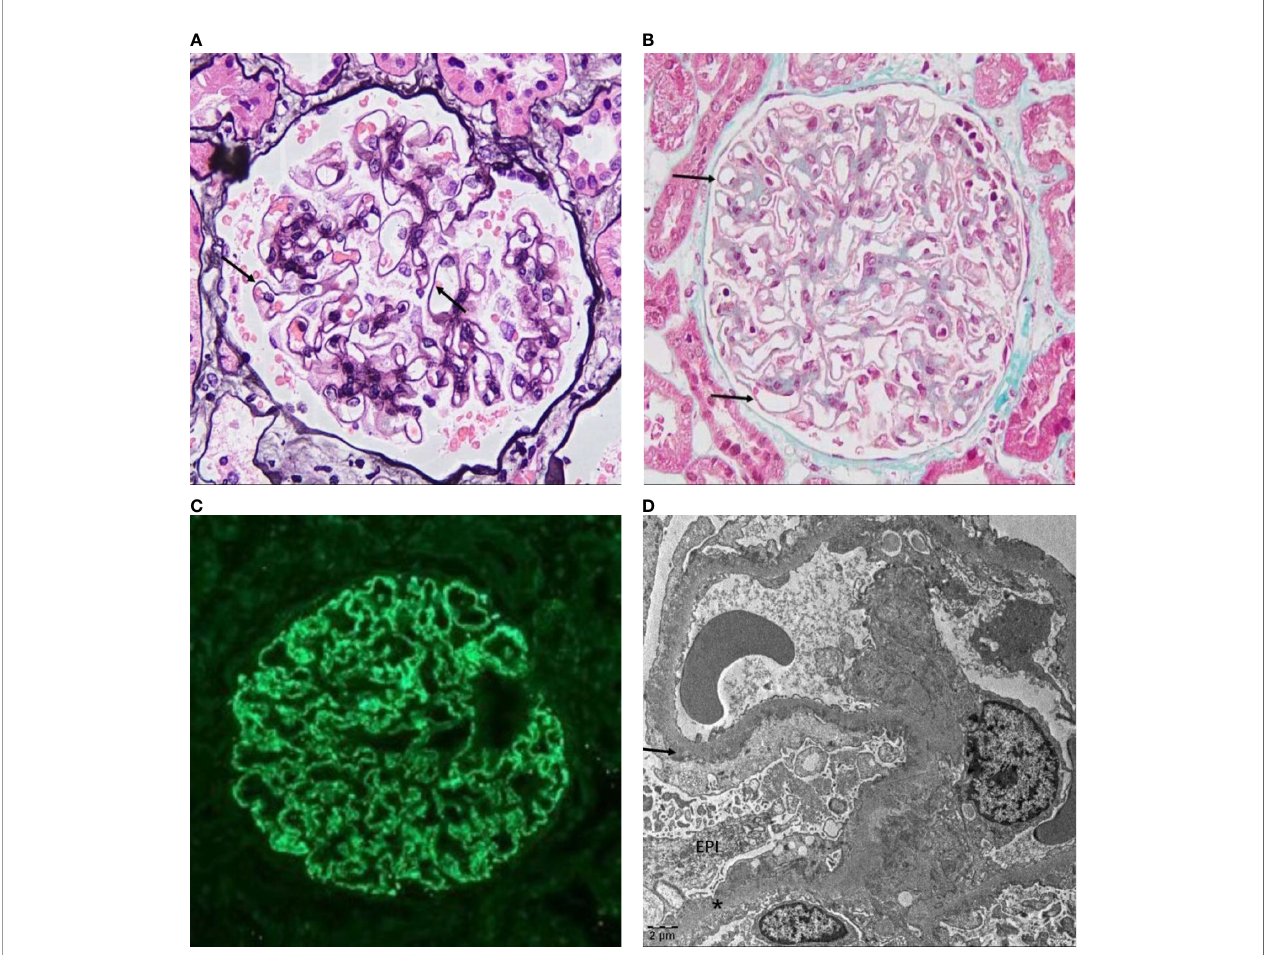
FIGURE 1 | Pathological features of IMN. (A) Glomerulus from a patient with IMN showing the thickened GBM (arrow) under a light microscope stained with PASM (original magni fi cation, 400×) and (B) pathognomonic antigen – antibody immune complex deposition on the epithelial side (arrow) stained with Masson (original magni fi cation, 400×). (C) Immuno fl uorescence microscopy in IMN showed IgG (+++), fi ne granular deposition along capillary loops. (D) Electron micrograph of IMN showed that the GBM is irregularly thickened, the foot processes are diffusely fused, and more electron-dense deposits (arrow) can be seen under the epithelium (EPI) and in the basement membrane (*) (images were based on pathological data for renal biopsy cases in the Department of Nephrology of Shengjing